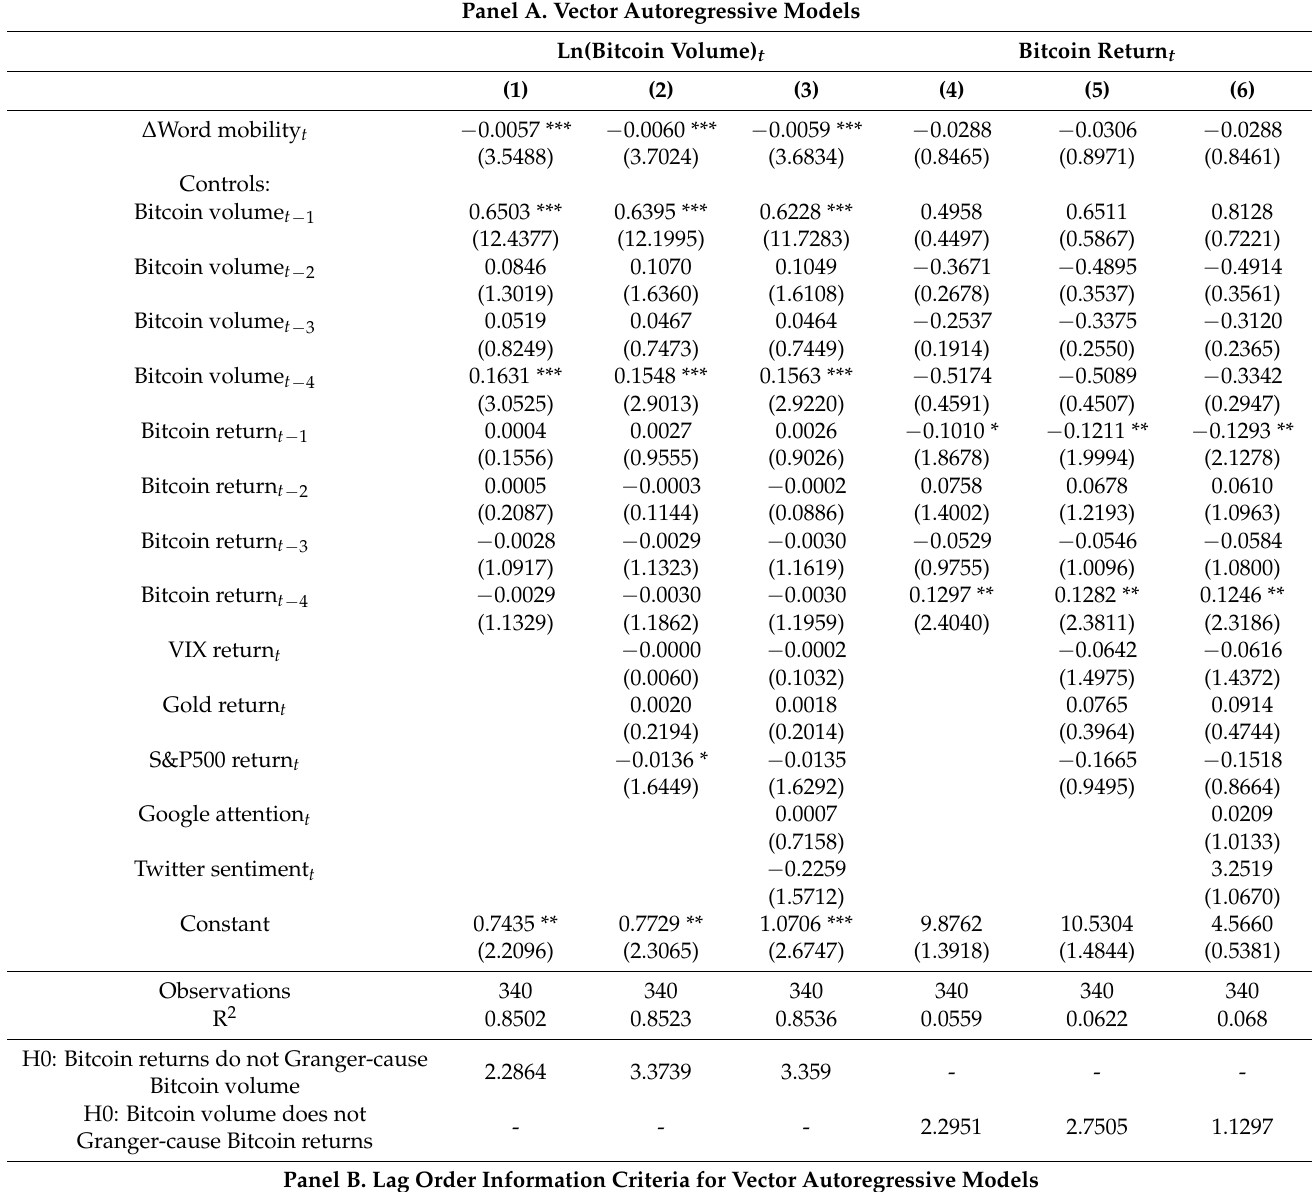
Table 3. Dynamic relationships among mobility, Bitcoin returns, and trading volume. Panel A. Vector Autoregressive